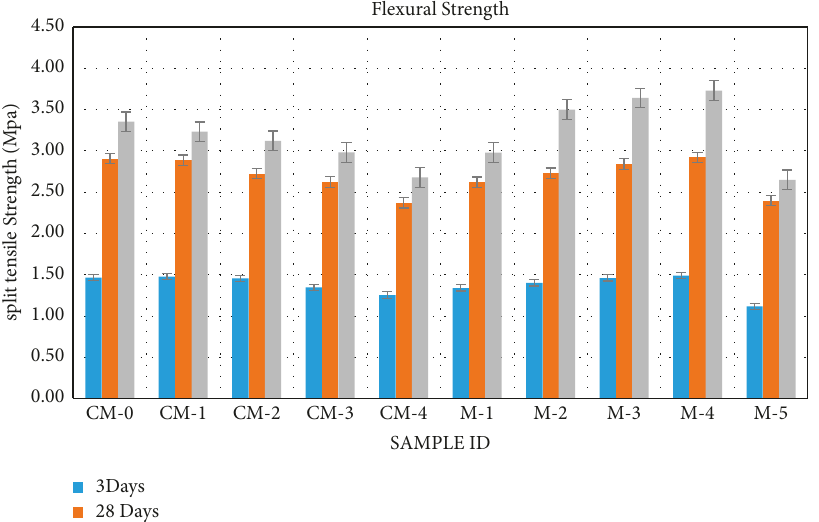
Figure 9: Split tensile strength development.